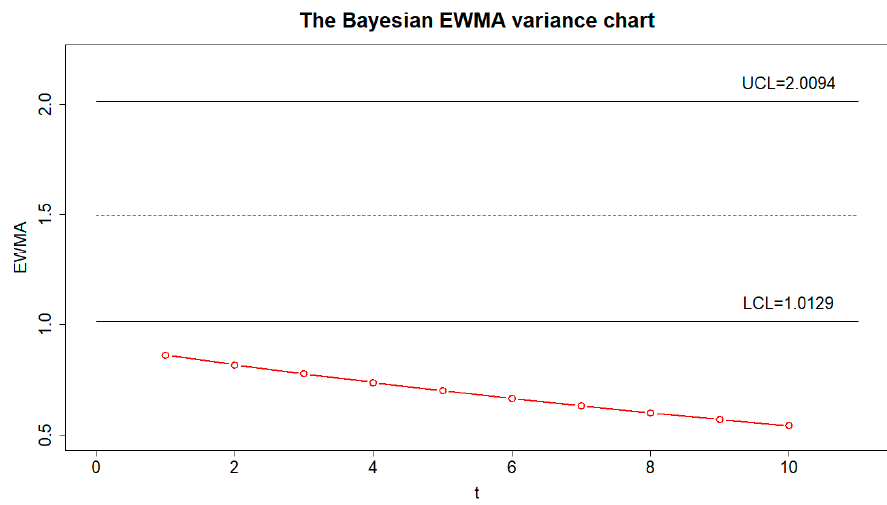
Figure 3. The Bayesian EWMA variance chart under the out-of-control process.